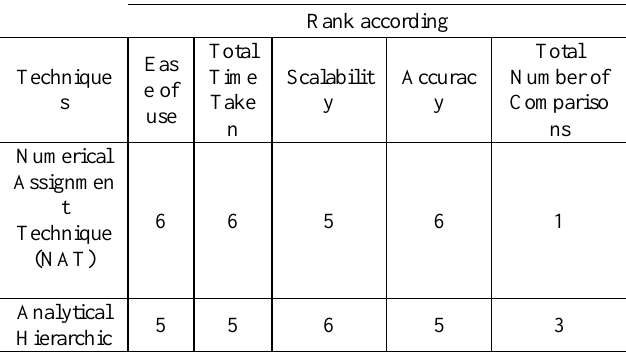
Table 1. Comparison of different analysis techniques